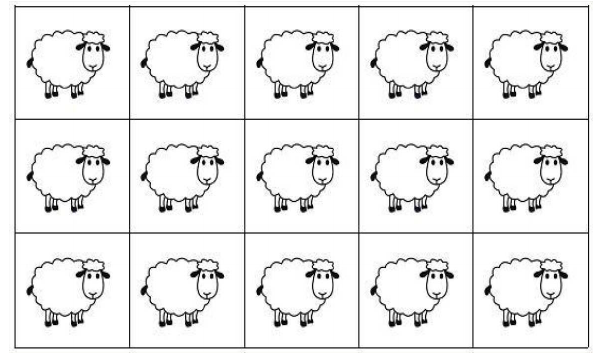
Fig. 1 Prey is analogous to sheep without